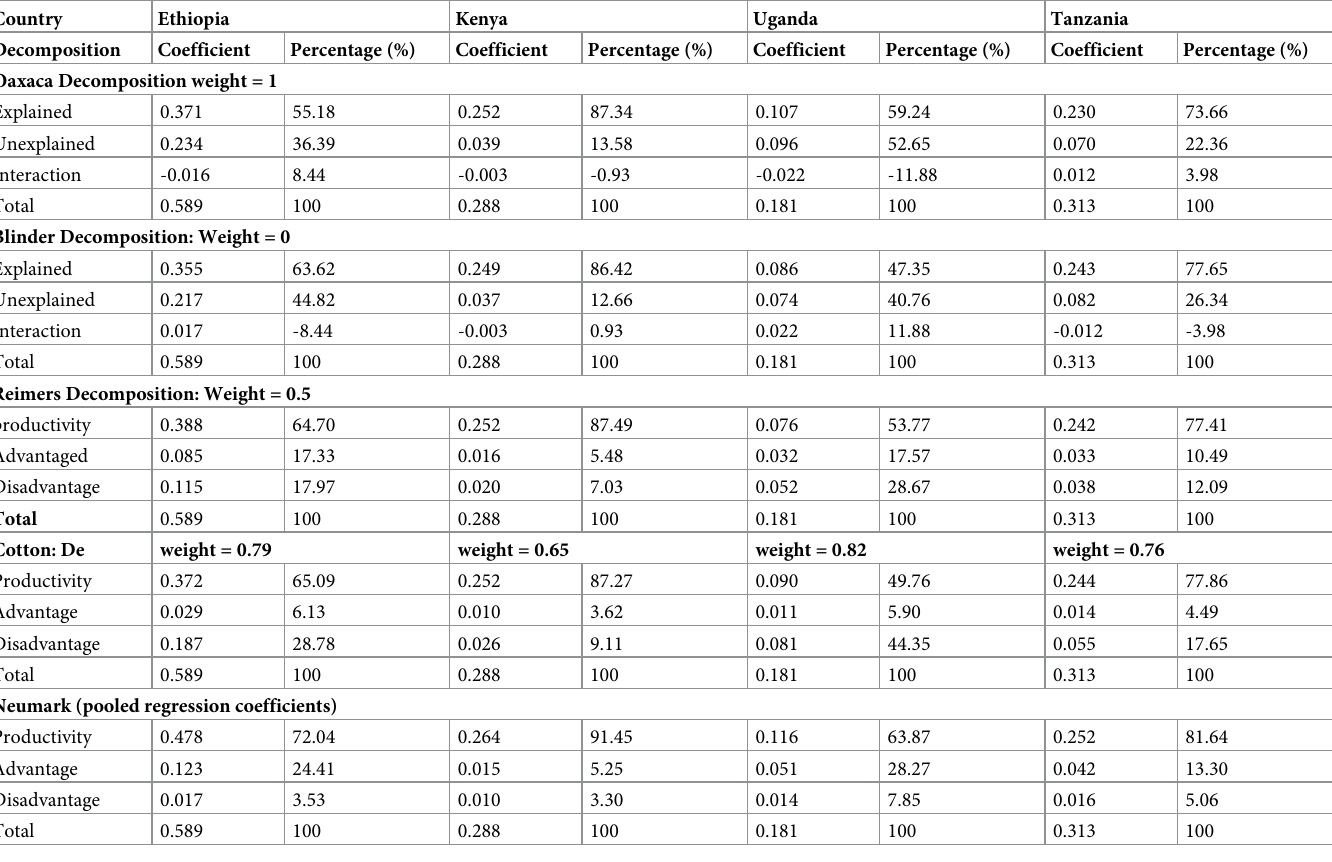
Table 2. Three fold decomposition estimates of place of delivery by residence in the selected